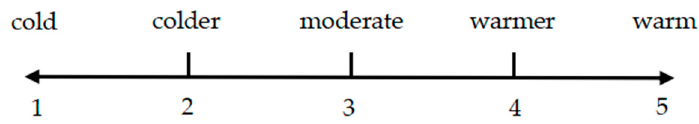
Figure 2. Quantitative grading of the cold-warm semantic dimensions.